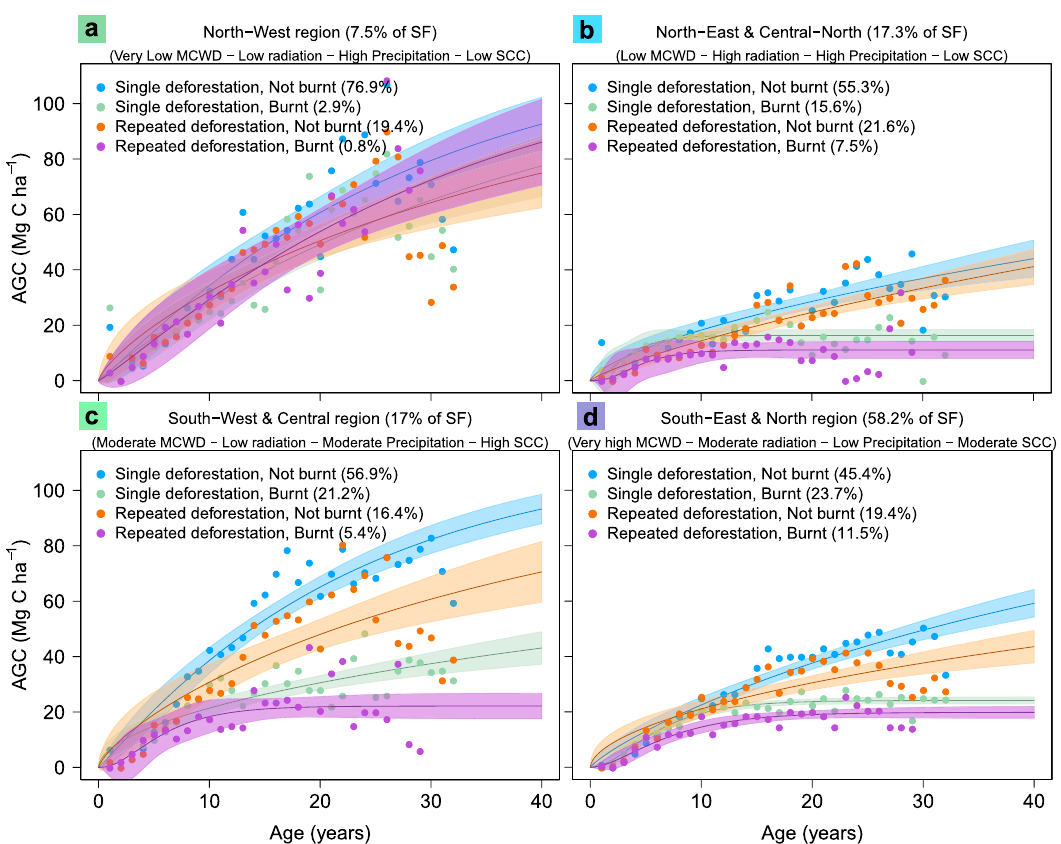
Fig. 3 The effect of disturbance on region-speci fi c regrowth models of carbon accumulation in secondary forests. The secondary forest regrowth models are shown for the regions identi fi ed in Fig. 2a. In each region, the climatological variables of Maximum Cumulative Water De fi cit (MCWD), annual average shortwave radiation and annual average precipitation are: a North-West region, b North-East and Central-North region, c South-West and Central region, d South-East and North region. The legend colours represent percentage of secondary forests that are affected by the type of disturbance in each region prior to regrowth, namely: blue — No disturbance ( “ Single deforestation, Not burnt ” ), green — Only fi re disturbance ( “ Single deforestation, Burnt ” ), orange — Only deforestation disturbance ( “ Repeated deforestation, Not burnt ” ), purple — Both disturbances ( “ Repeated deforestation, Burnt). Shading denotes the 95% con fi dence interval of the models based on the median value of the initial data for each age — dots in fi gures. See Supplementary Table 9 for quantitative interpretations of the qualitative de fi nitions given here, for example “ Low precipitation ” . The abbreviation SCC in a – d refers to Soil Cation